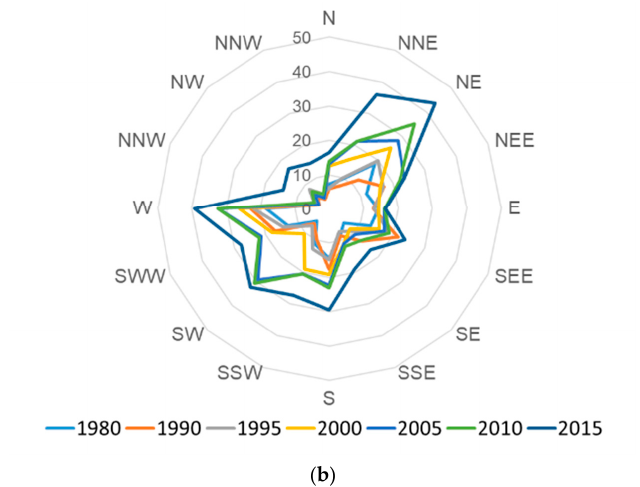
Figure 3. Spatial and temporal dynamics of urban expansion in Xi’an between 1980 and 2015: ( a ) urban built-up area in 1980 and new urban built-up area for the different time steps; and ( b ) spatial orientation and distance (in km) from the Xi’an urban center of urban expansion for the different time steps between 1980 and 2015.